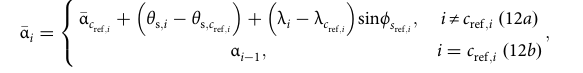
For the species simulations, optimal inherited headings were determined using the MATLAB nonlinear solver fminbnd , among candidate initial headings clockwise from East ( − 90° clockwise from S) to West (90°). For sun compass courses, which can potentially begin with Northward headings 34,64 , we tested initial headings between NE ( − 145°) and NW (145°). Error scenarios were assessed for both 5° – 60° directional precision among fl ight-steps, and biologically relevant scenarios with 5° – 40° compass precision in 5° intervals (assuming equivalent precision in cue detection, transfers and maintenance), and both in the absence of and including 15° within- fl ight drift. To result in 15° expected drift per fl ight step, hourly concentration in drift was adjusted as an autocorrelated process with lag 1. We further assumed a default between-individual variability of 2.5° ( κ = 525, circular length = 0.999). For the marsh warbler uncertainty analysis (Fig. 6), we varied this between 0° and 10° ( κ = 33, circular length = 0.985) in 1° interval, and also tested 20° within- fl ight drift. For the generic migrants, we simulated migration between 65°N – 0°N and between 45°N – 25°N to a goal with a radius of 500km, for biologically relevant scenarios with 0° – 60° compass precision in 1° interval, and both in the absence of and including 15° within- fl ight drift. To obtain all possible routes between these latitudes (Fig. 5a), we varied initial (inherited) headings in 0.5°